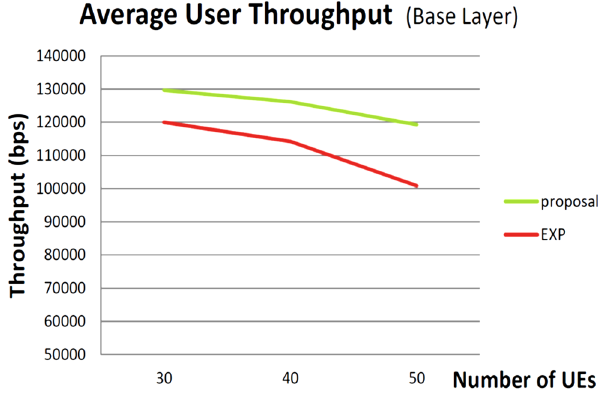
Figure 11. Average user throughput (UE velocity = 30 km/h).